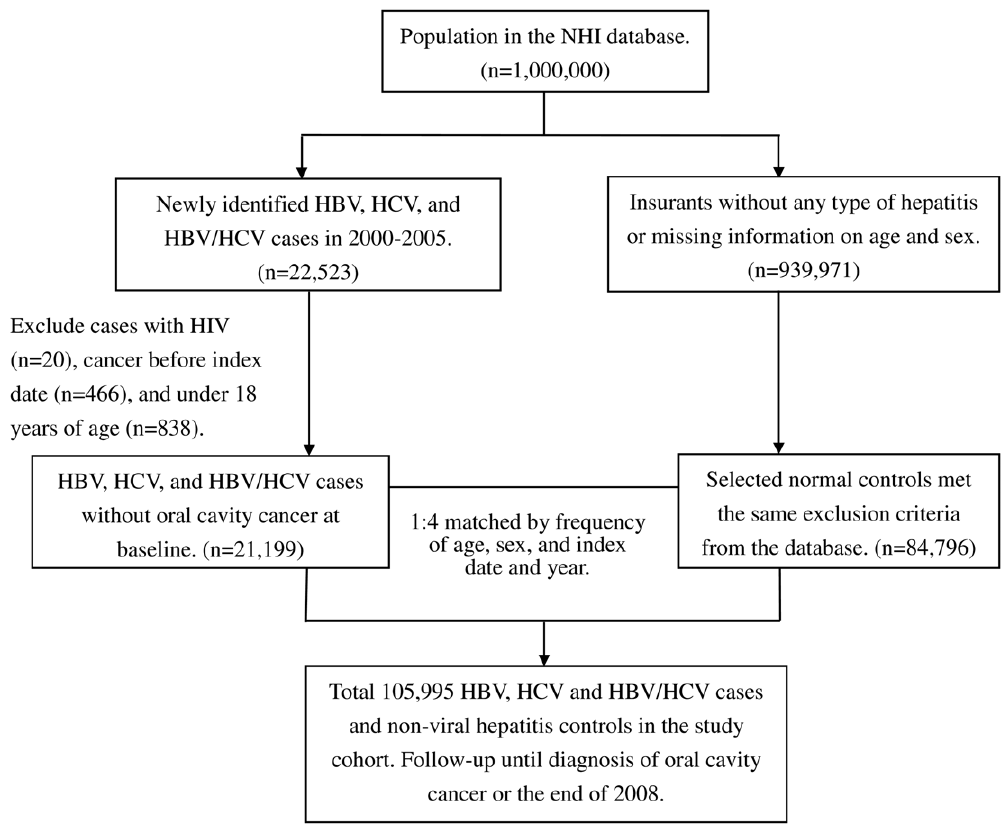
Figure 1. Study flow chart showing the selection of subjects. Footnotes: NHI, National Health Insurance.